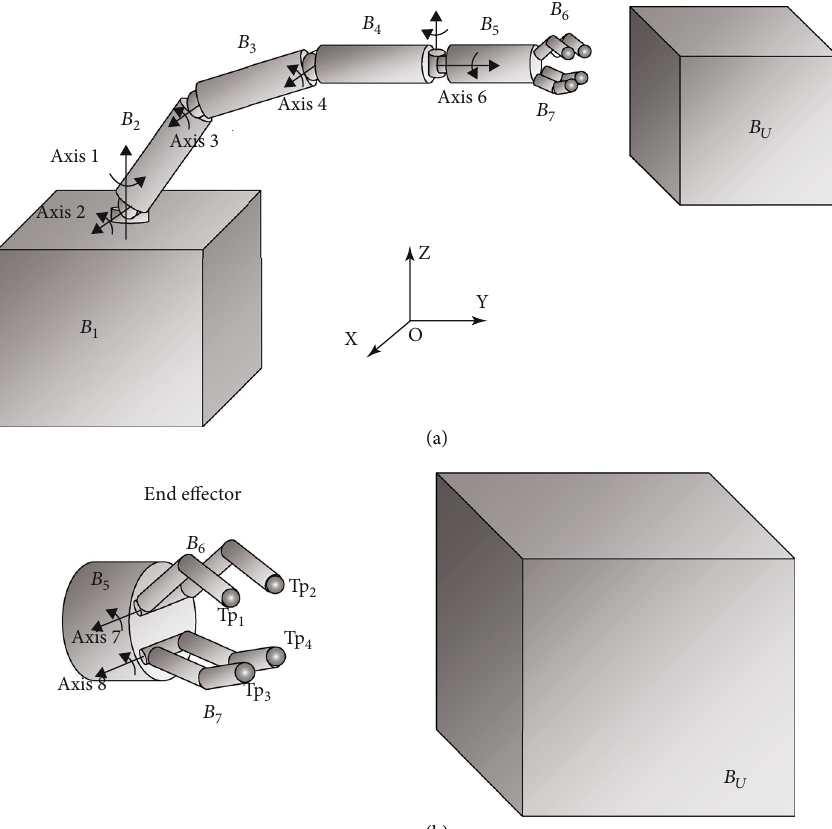
Figure 1: Space robot and the noncooperative satellite to be captured: (a) the total diagram of the system; (b) enlarged drawing of the end e ff ecter and the target